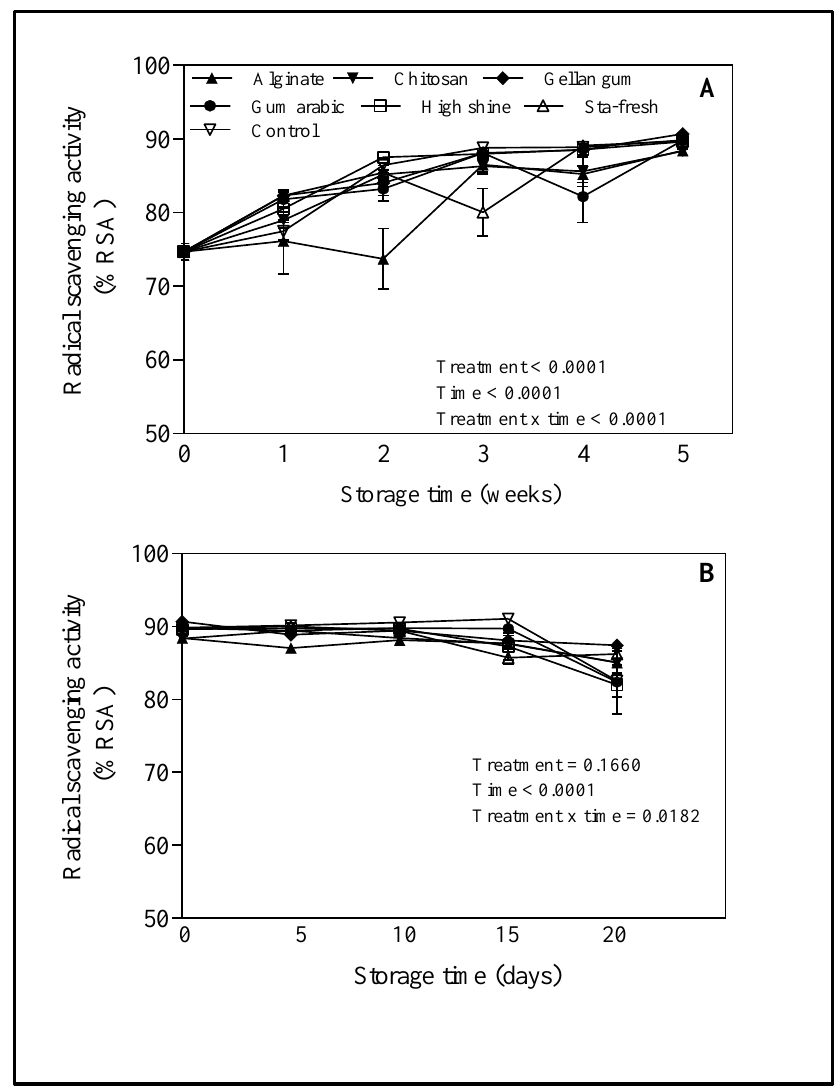
Figure 5. Radical scavenging activity (%RSA), based on 2,2-Diphenyl-1-picryl-hidrazil (DPPH) radical scavenging method, in plums (‘African Delight™’) during ( A ) a simulated shipping period (cold storage; − 0.5 ± 2 ◦ C and 90 ± 5% RH for 5 weeks) and ( B ) shelf life (20 ± 2 ◦ C and 75 ± 5% for 20 d). Means ± standard errors presented. In other to determine the interaction e ff ects, factorial ANOVA was performed for main factors; treatment and storage time separately for cold storage and shelf life